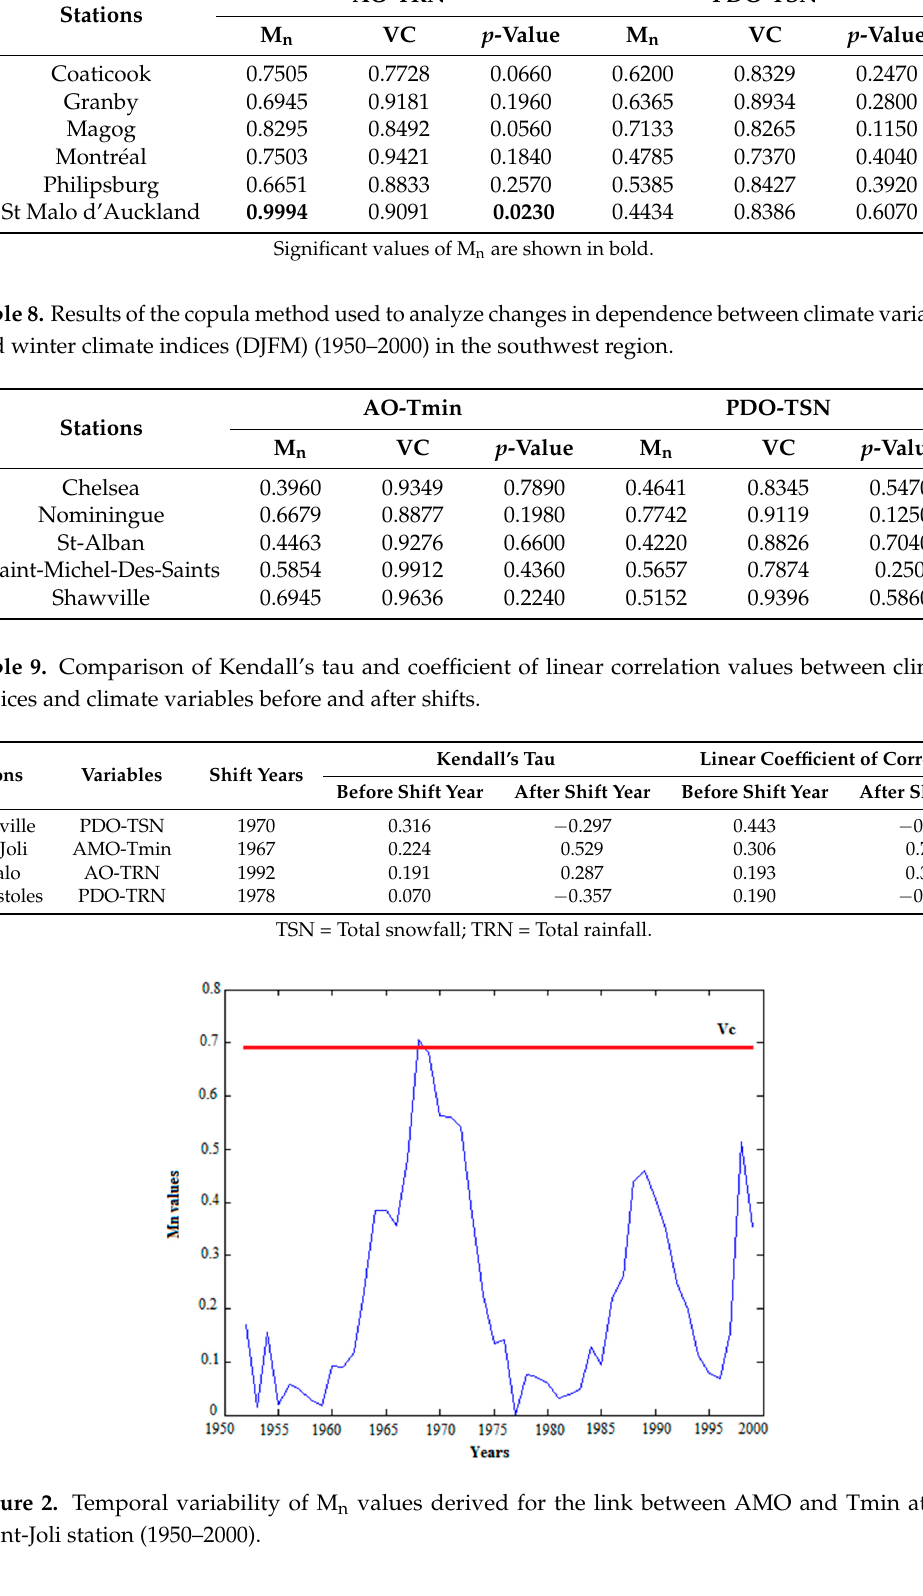
Table 7. Results of the copula method used to analyze changes in dependence between climate variables and winter climate indices (DJFM) (1950–2000) in the southeast region.